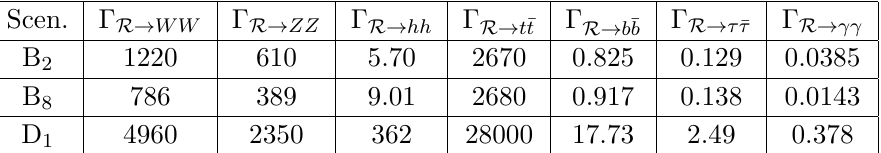
Table 4 . Partial widths of the radion in the scenarios B 2 , B 8 and D 1 . All widths are in MeV units. Scen.